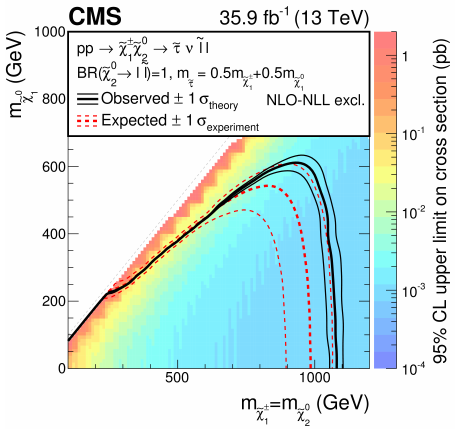
Figure 14: Interpretation of the results in the τ -enriched model with mass parameter x = 0.5 [ 20 ] .